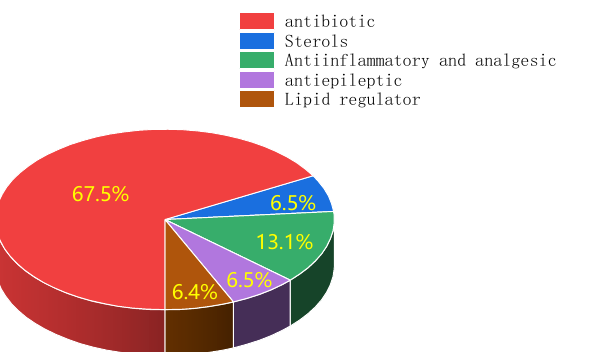
Figure 4. The main categories of detected pharmaceutical contaminants in urine (data from